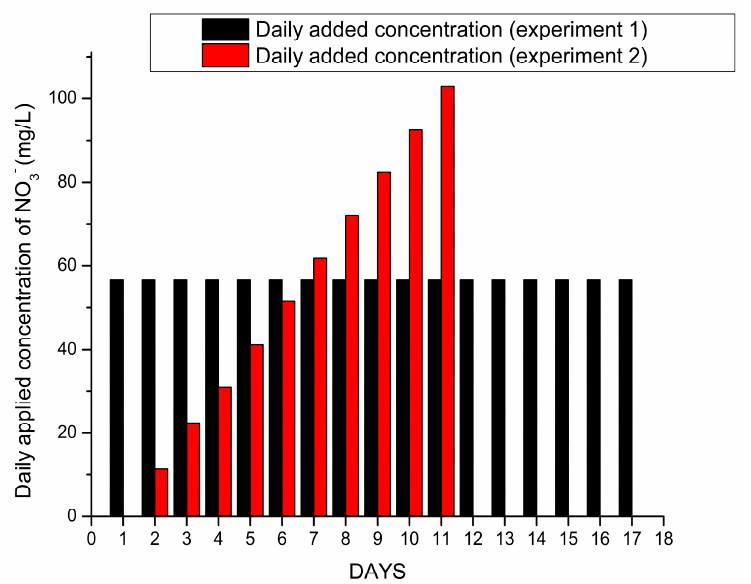
Figure 2. Daily applied concentration of nitrate during experiment 1 (C1, C2, and C3) and experiment 2 (C4, C5, and C6).